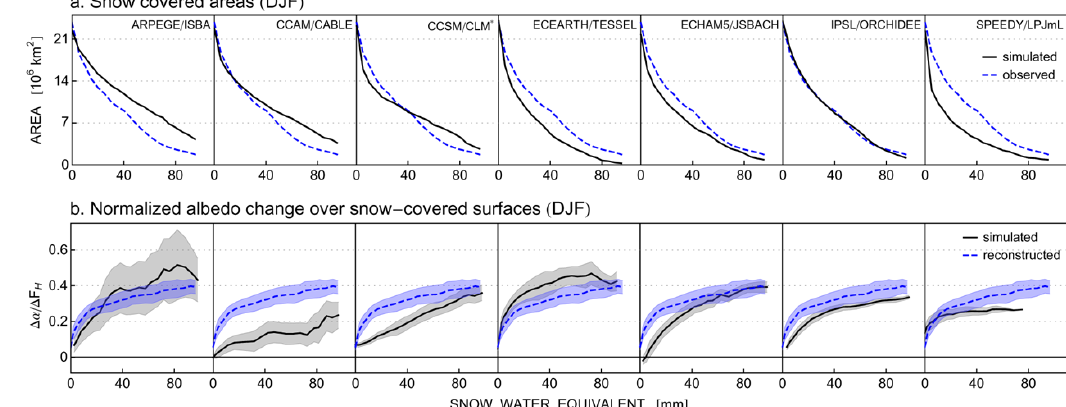
Fig. 8. (a) Total area within the region of study (box in Fig. 5) in DJF with snow water equivalent (SWE) levels higher than the value indicated in the x-axis. Solid and dashed lines illustrate the snow coverage/content relation simulated in LUCID models and obtained from the NISDC dataset, respectively. (a) Normalized surface albedo changes ( 1α/1F H , see text) averaged over SWE bins of 15mm around the values indicated in the x-axis. Results from simulations and reconstructions illustrated as solid and dashed lines, respectively. Shaded areas indicate the corresponding ± 1 standard deviation of 1α/1F H calculated within the moving window at each SWE level. Table 3. Simulated and reconstructed annual mean LCC-induced change in surface albedo ( × 100) averaged over the global ice-free land (excluding Greenland and Antarctica).